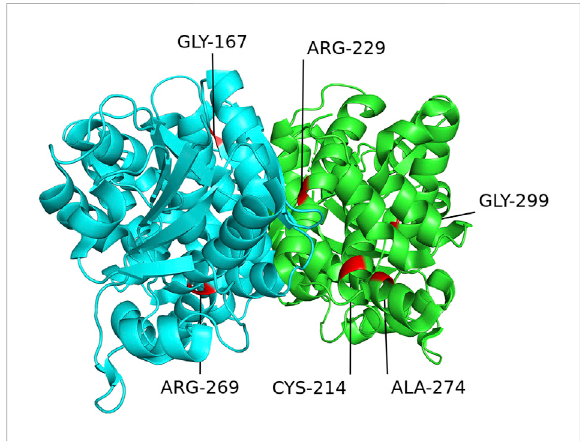
FIGURE 6 Schematic diagram of protein structure of mutation loci of the glycerol-3-phosphate dehydrogenase 1 ( GPD1 ) gene. This diagram shows the location of the GPD1 missense mutation sites in the protein structure (dimer) in patients with transient infantile hypertriglyceridemia (HTGTI): it mainly exists in the dimer binding surface (R229Q), active site (R269Q), helical bundle (C214R, A274T), near active site (Q299R), and β -folding (G167D). These protein structures of GPD1 were drawn using PyMOL